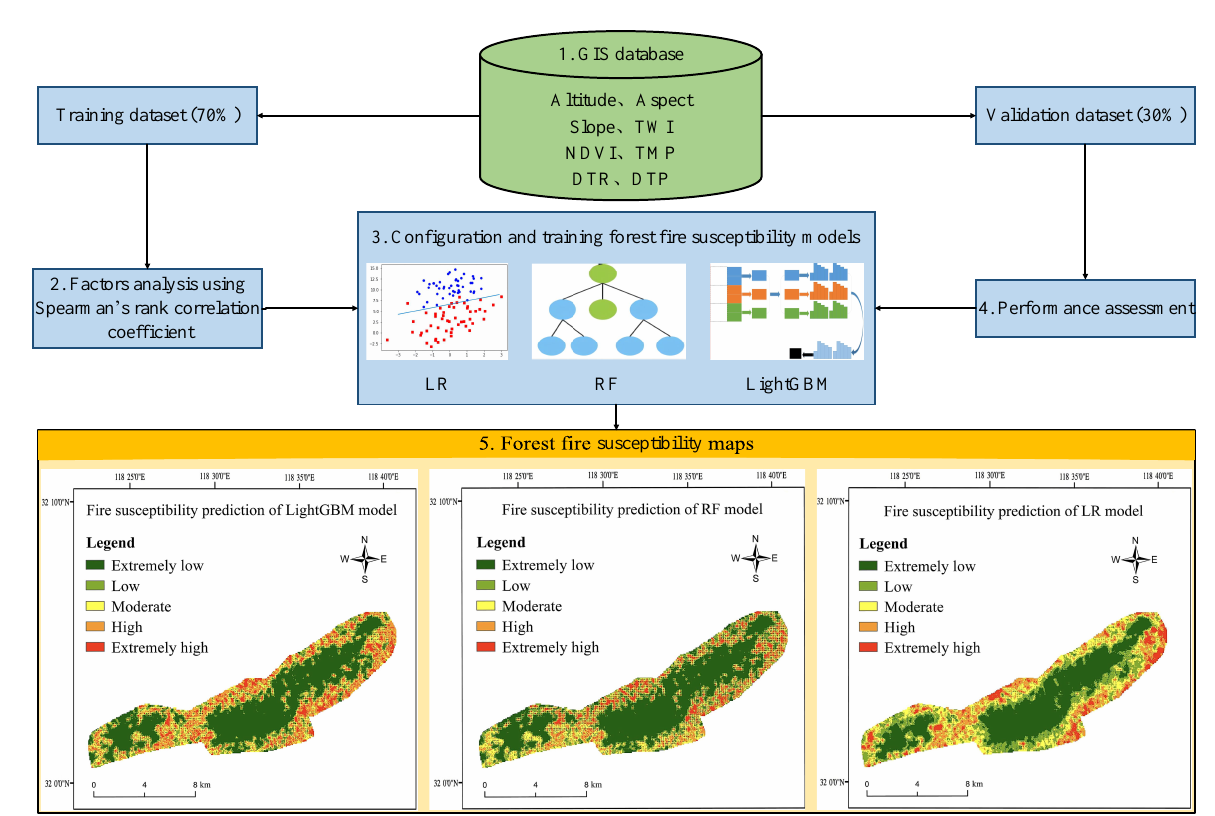
Figure 1. The general workflow shows the interaction from data input to the produced fire suscepti- bility map.